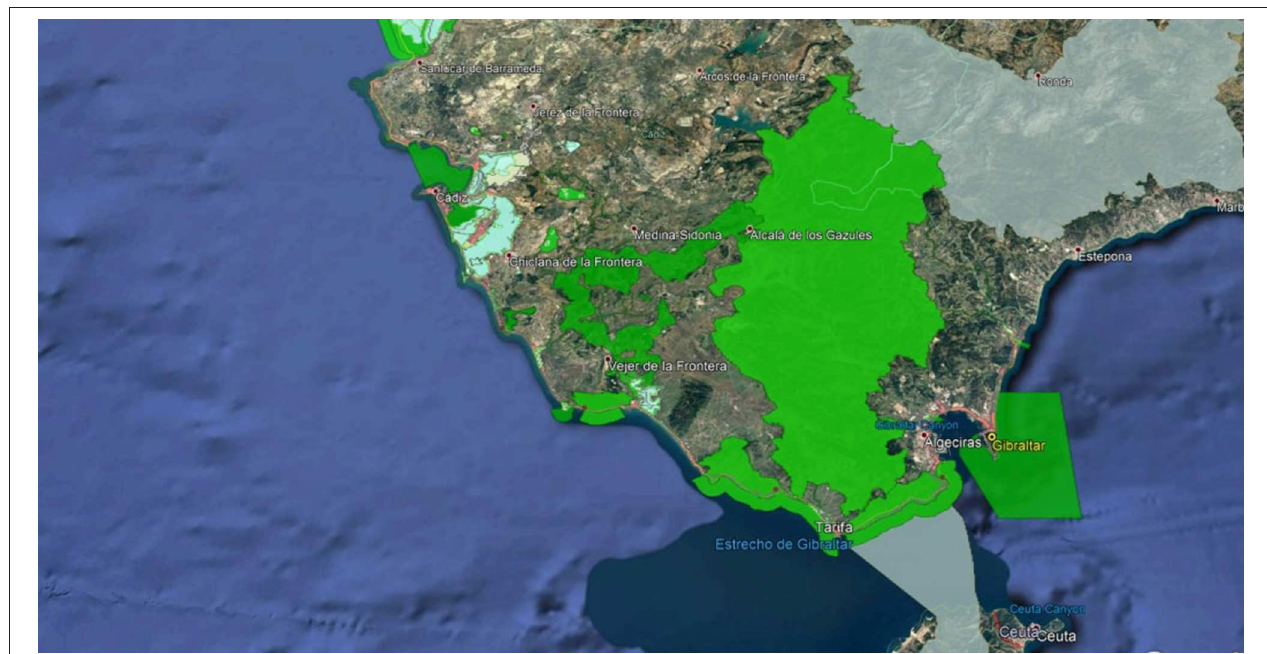
FIGURE 15 | Areas for the installation of offshore projects (green—apt, yellow—apt with conditions, red—excluded). Reproduced from Spanish Ministry (Spanish Ministry of Energy, 2009).